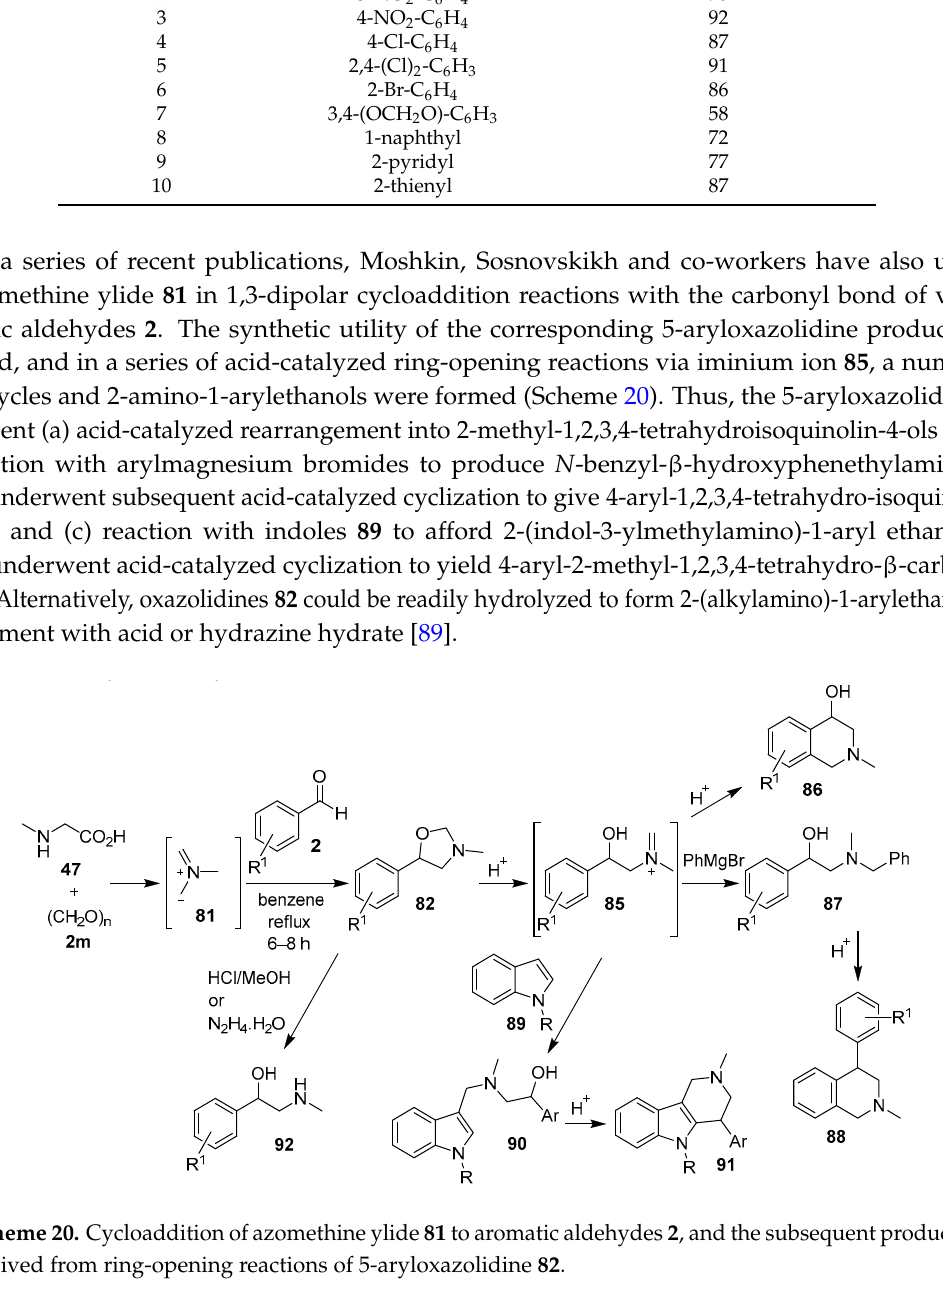
Table 11. Cycloaddition of azomethine ylide 81 to aldehydes 2 (Scheme